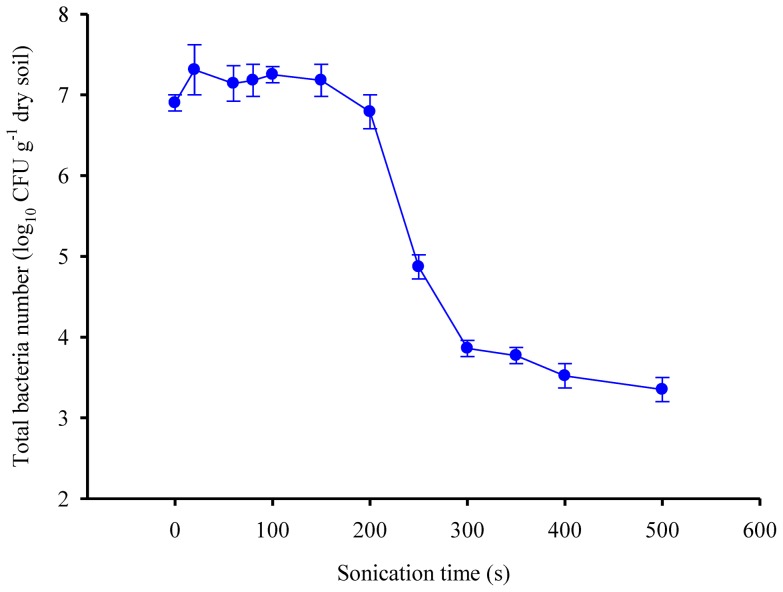
Total bacteria number of field-moist soil as a function of sonication time.